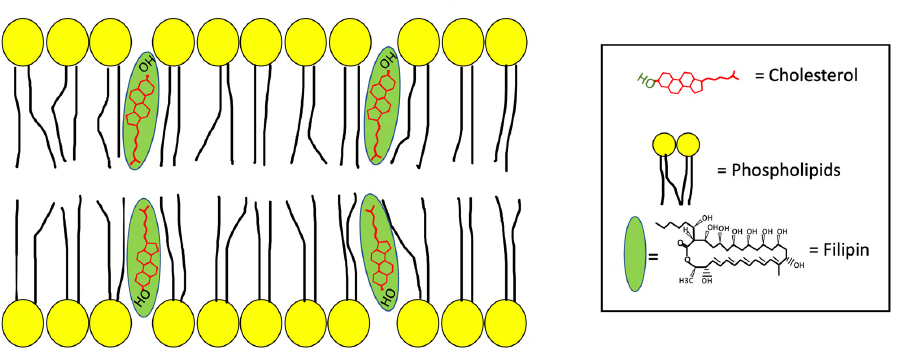
Figure 2. The binding of filipin to cholesterol in the plasma membrane.